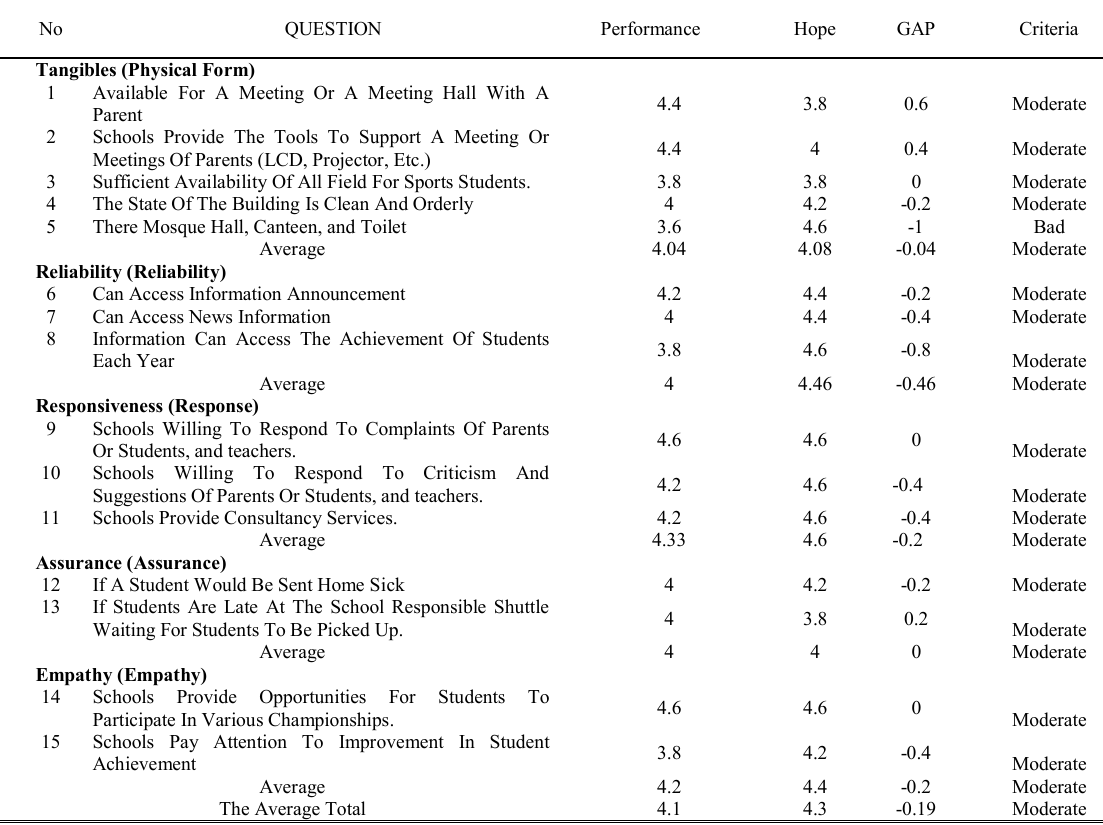
TABLE 3. V ALUE S ERVICE Q UALITY P ARENTS